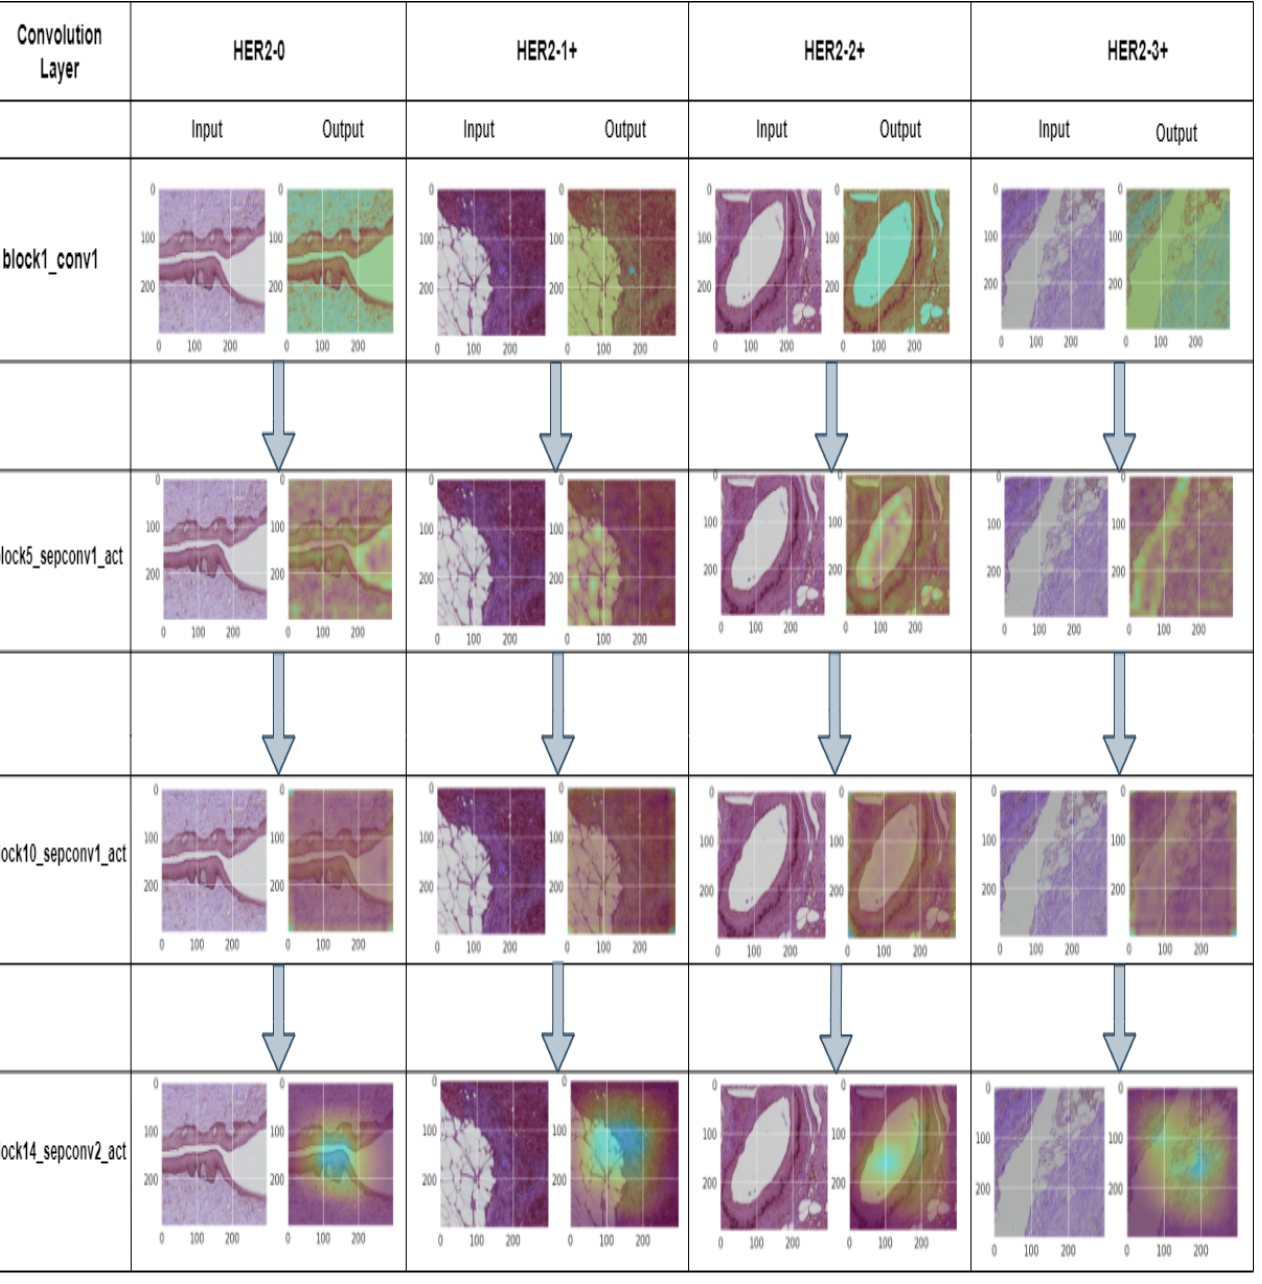
Figure 10. This figure explains our proposed model-‘HE-HER2Net’, for different convolution layers generating